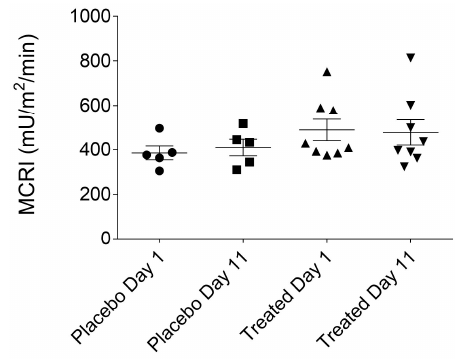
Figure 5. MCRI (metabolic clearance rate of insulin) of the placebo- and fenugreek-treated subjects.